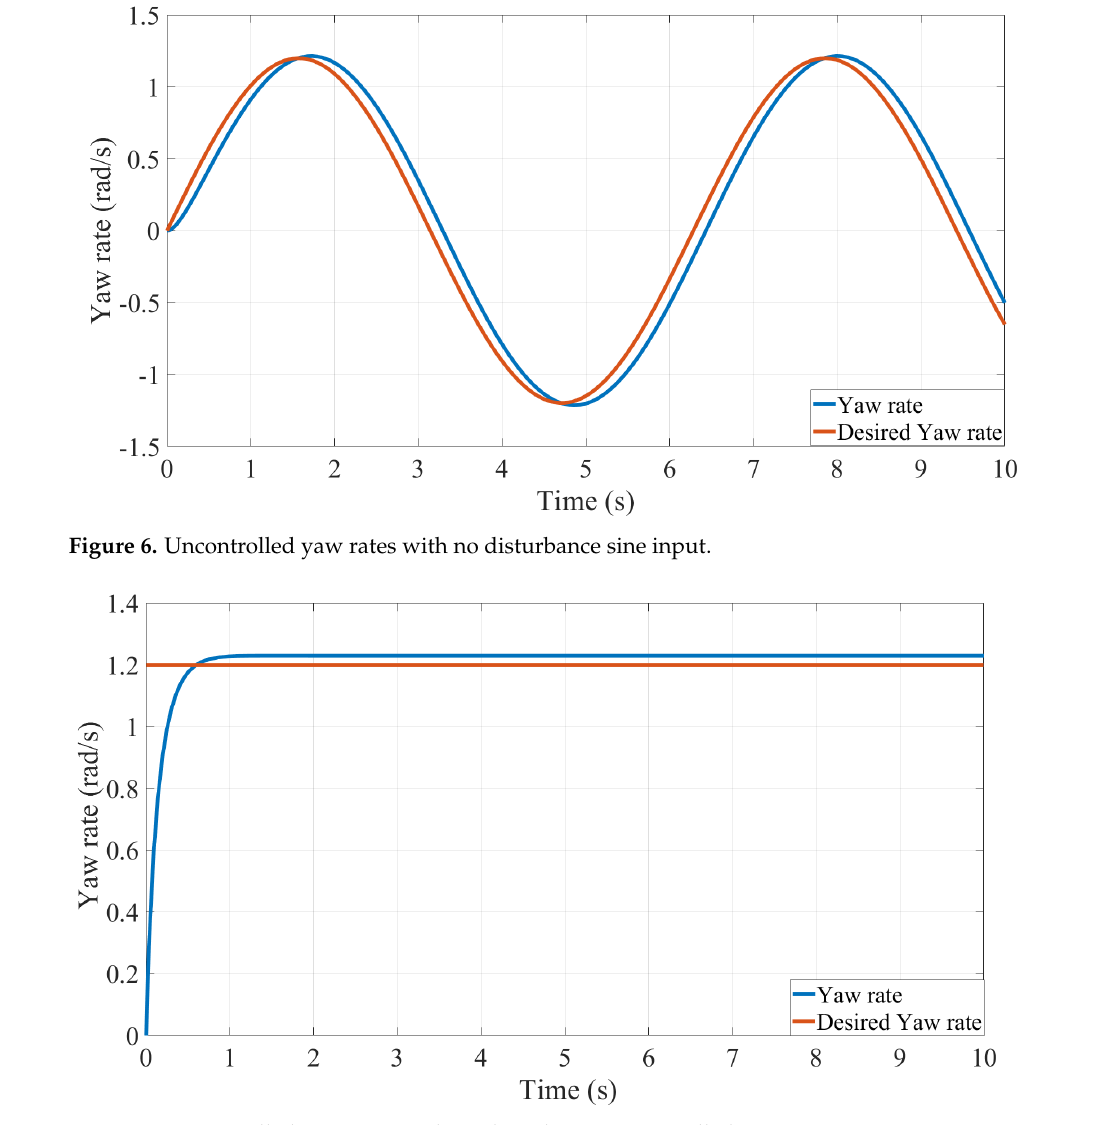
Figure 7. Uncontrolled yaw rates with no disturbance uncontrolled constant